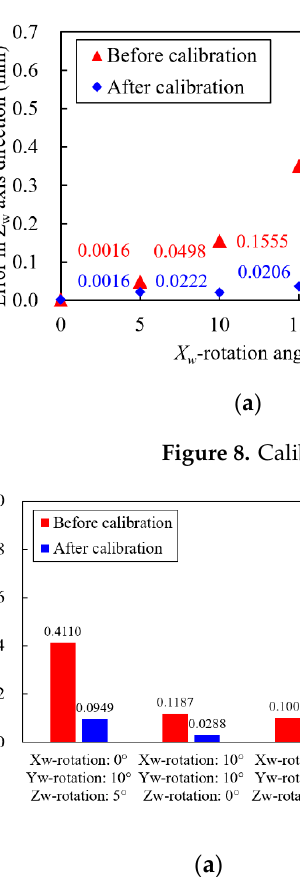
Figure 9. Measurement errors in the cases of complex rotation. ( a ) Errors in Z w axis direction; ( b ) Errors in X w axis direction.